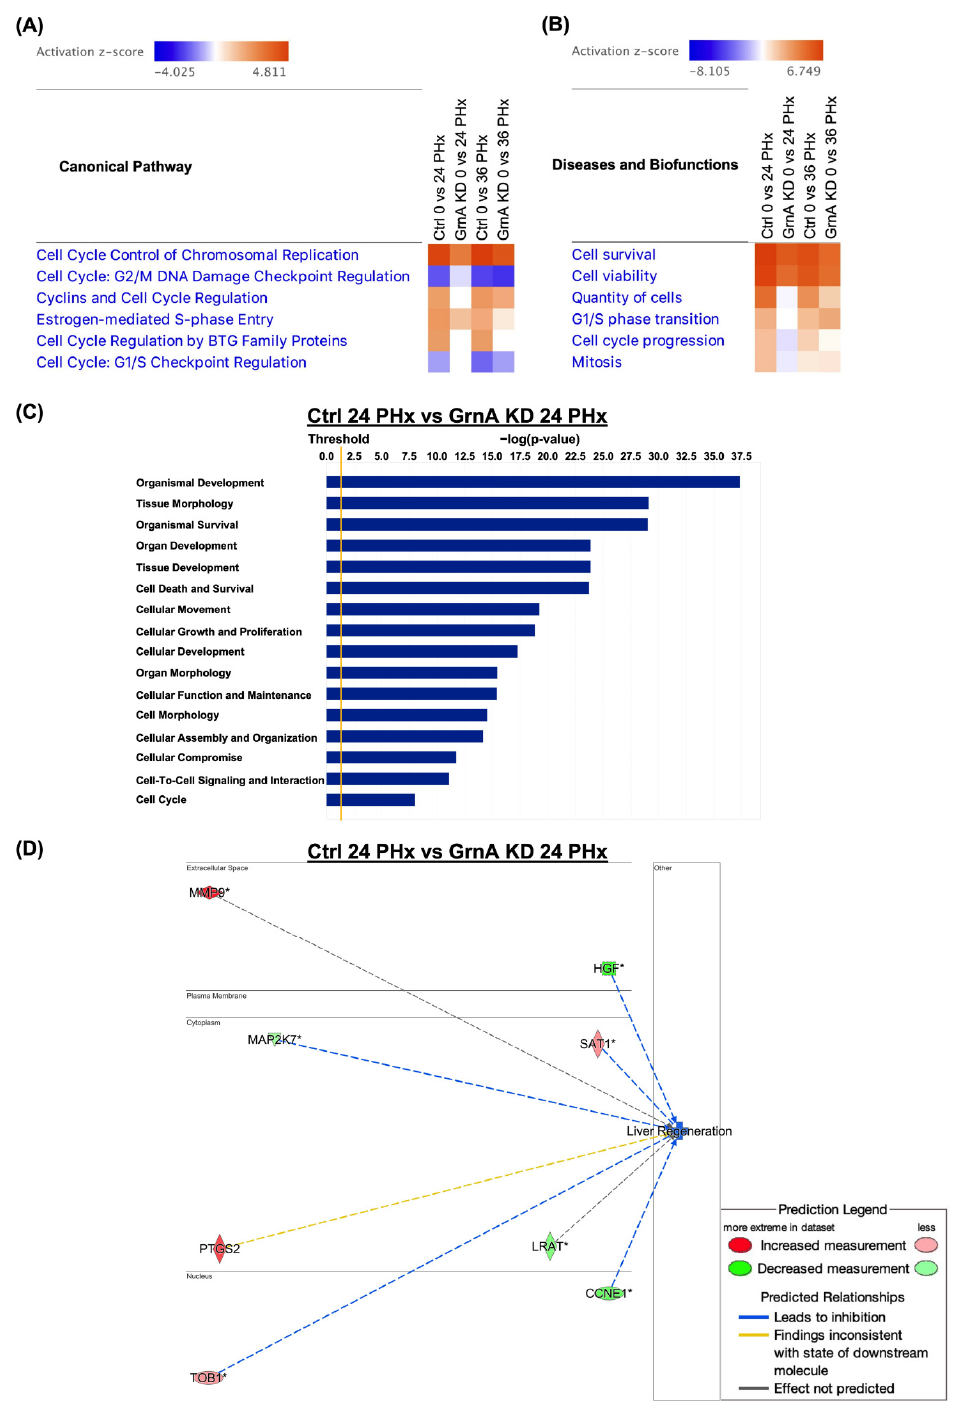
Figure 3. Canonical pathway, and functional and gene interaction network analyses of control and GrnA Mo-treated animals at 0, 24, and 36 h after PHx. ( A ) Heatmap shows canonical pathway analysis in comparison to control and GrnA Mo treatments at 24 and 36 h after PHx versus 0 h after PHx. ( B ) The heatmap shows disease and biofunctional analyses of control and GrnA Mo treatment at 24 and 36 h after PHx versus 0 h after PHx. Activation z-score indicates activation states of upstream transcriptional regulators: “activated” (orange) or “inhibited” (blue). Significantly activated or inhibited indicates an overlap p -value ≤ 0.05 and an z -score ≥ 1.5 (or ≤− 1.5). ( C ) The top ranked diseases and biofunctions in control Mo versus GrnA Mo treatment at 24 h PHx. The threshold line represents a p -value of 0.05. ( D ) The gene interaction network was predicted for liver regeneration. The lines represent direct or indirect gene-to-gene interactions, and the color represents fold change. The pathway, functional analyses, and network analyses were generated using IPA. * more than one ID linked to this